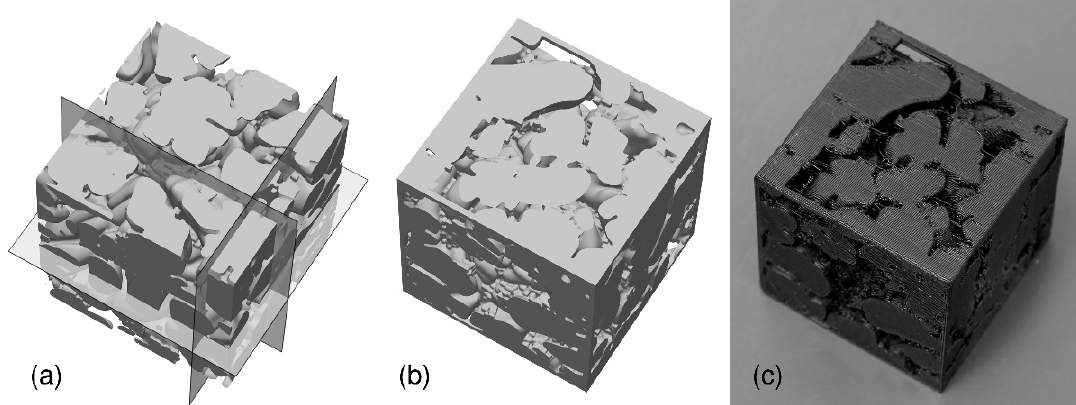
Figure 3. Microstructure geometry with an RVE edge length of 150 μ m before ( a ) and after ( b ) filtering, and scaled, additively manufactured microstructure sample ( c ) with an edge length of 5 cm. The structure has a solid fraction f S = 68.1%. The transparent planes in ( a ) indicate the new boundaries chosen for the filtering process.